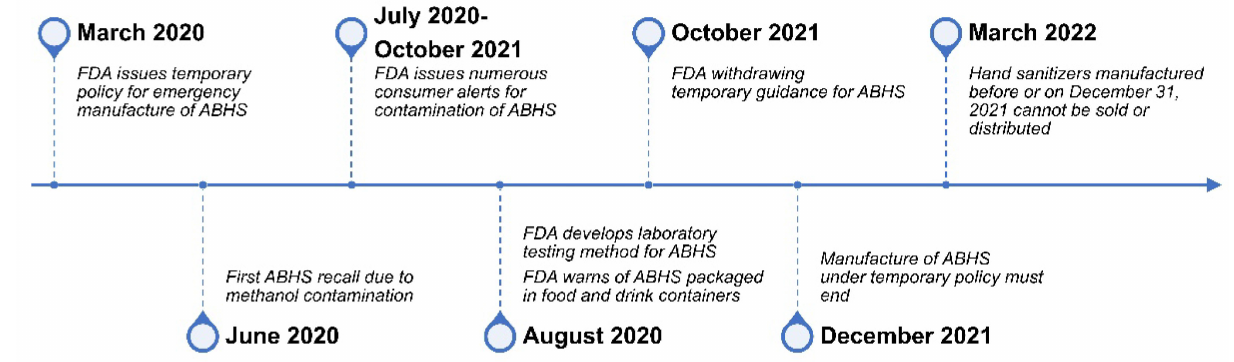
Figure 1. Timeline on Alcohol-Based Hand Sanitizer (ABHS)-Related U.S. Food and Drug Adminis- tration (FDA) Actions and